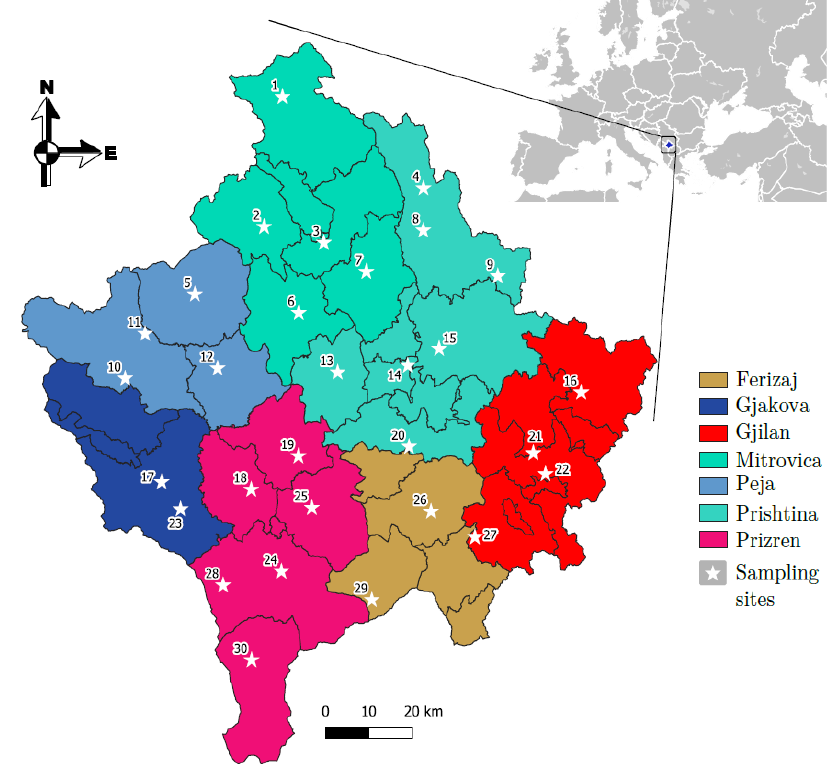
Figure 1. The map of Kosovo and the location of the sampling points.